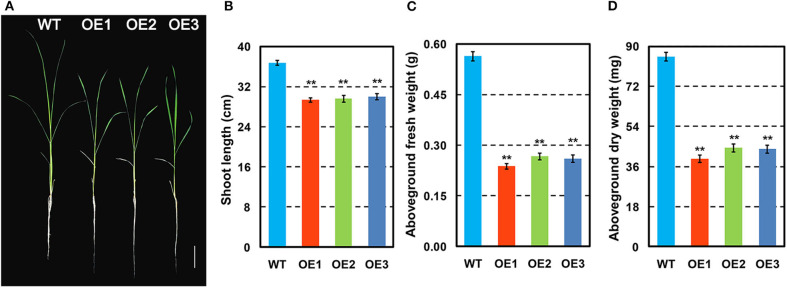
Phenotypes of OsCKX2 OE rice and WT at seedling stage. Plant morphology at seedling stage (A). Statistical analysis of shoot length (B), aboveground fresh weight (C), and aboveground dry weight (D). Data represents means ± SEM (n = 15). **P < 0.01. Scale bars: 5 cm.